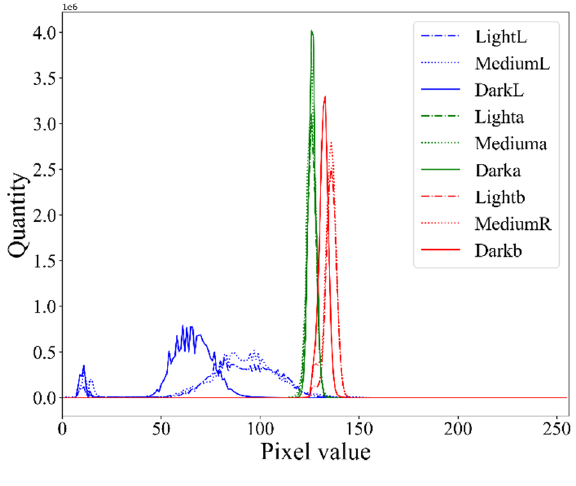
Figure 3. Color histogram of three wood colors in the ( A ) RGB, ( B ) HSV, and ( C ) Lab spaces.